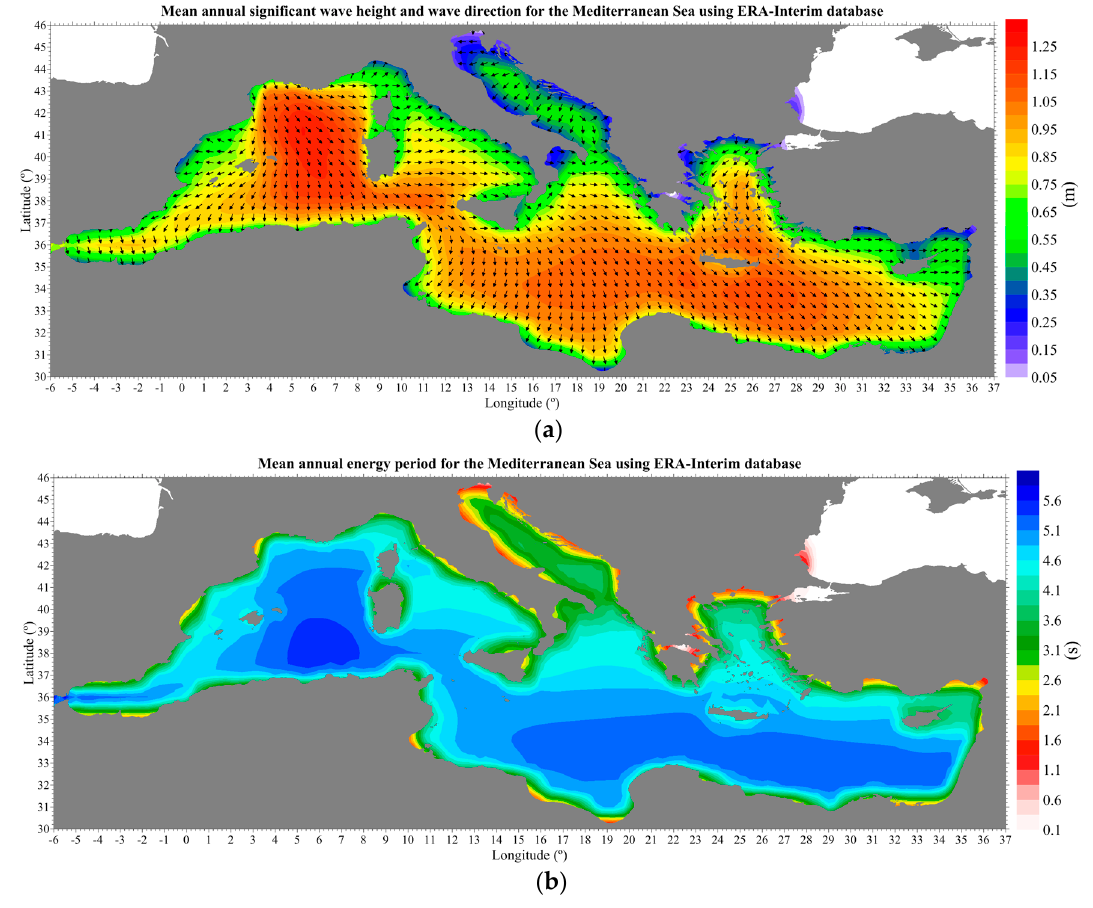
Figure 7. Mean annual wave climate in the Mediterranean Sea: ( a ) Significant wave height and mean wave direction; ( b ) Energy period. Data obtained from the ERA-Interim database (1979–2013) of the ECMWF and analyzed by HCMR.